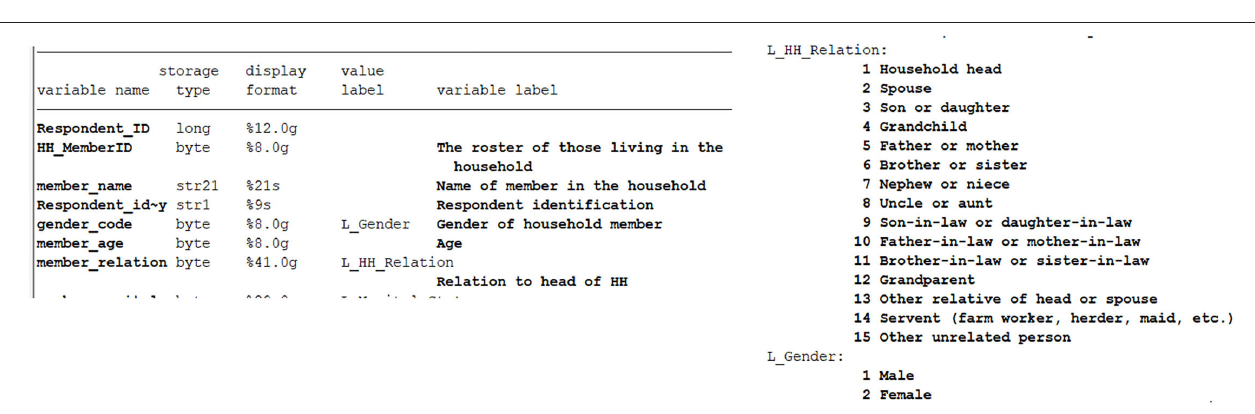
FIGURE 3 | Screen shot of an example data file of household composition. Personally identifiable information has been blacked out.